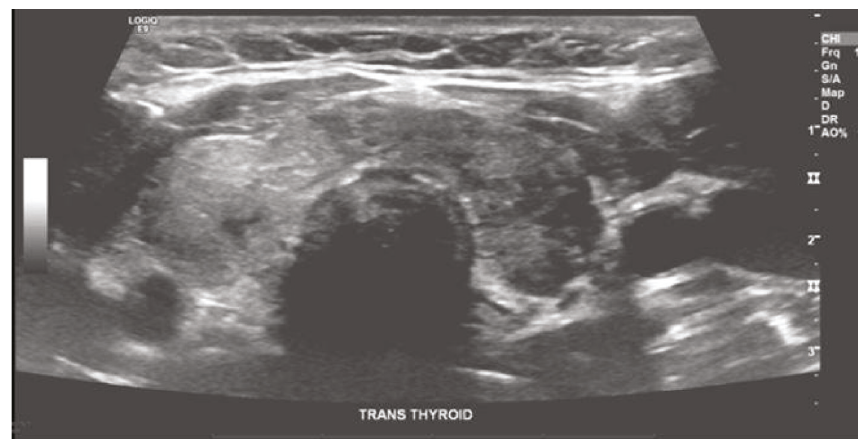
Figure 1: Ultrasound of the thyroid gland showing a heterogeneously enlarged thyroid gland with two small 4 mm solid hypoechoic solid nodules in the